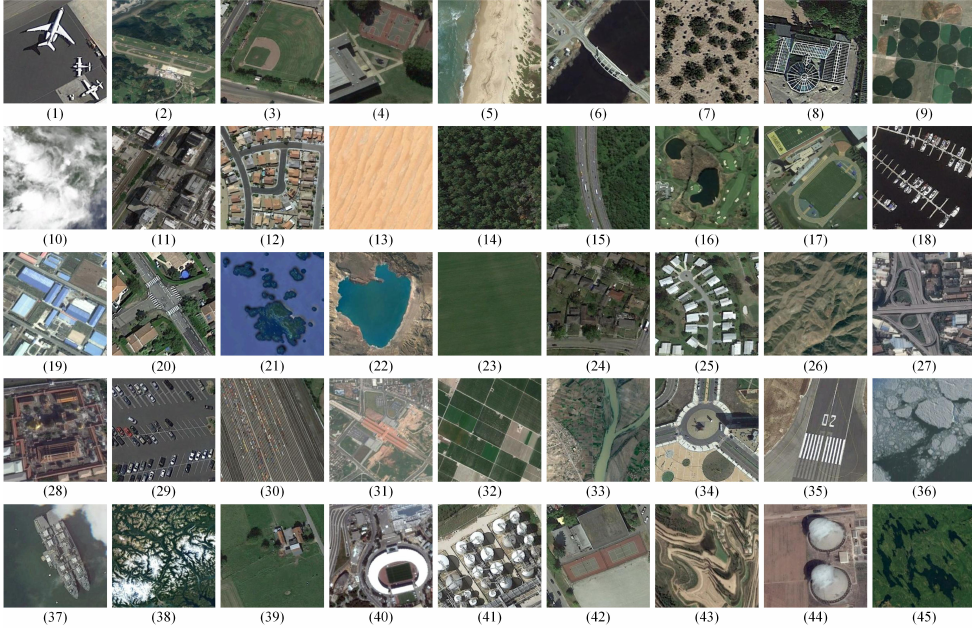
Figure 7. Examples of the NWPU-RESISC45